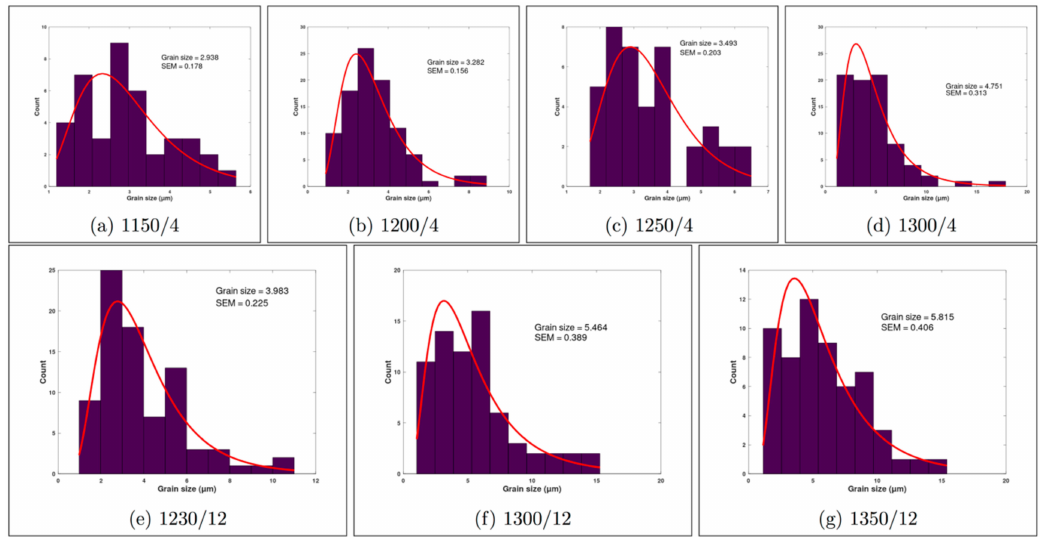
Figure 3. Size histograms at di ff erent sintering temperatures and times.